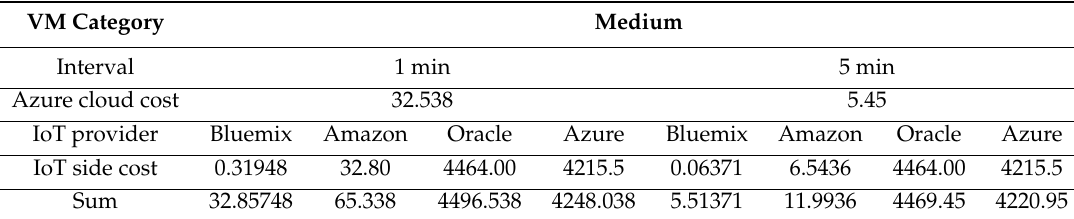
Table 4. IoT costs with a medium VM category in scenario N o 3.